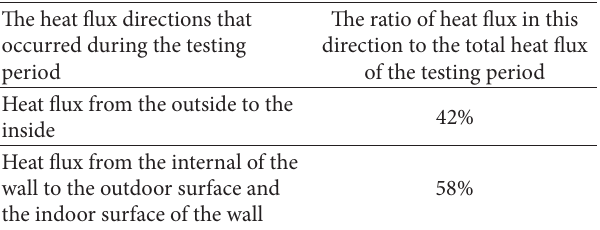
Table 1: The ratio of heat flux in each direction to the total heat flux under the conditions that air-conditioner runs continuously throughout the day.